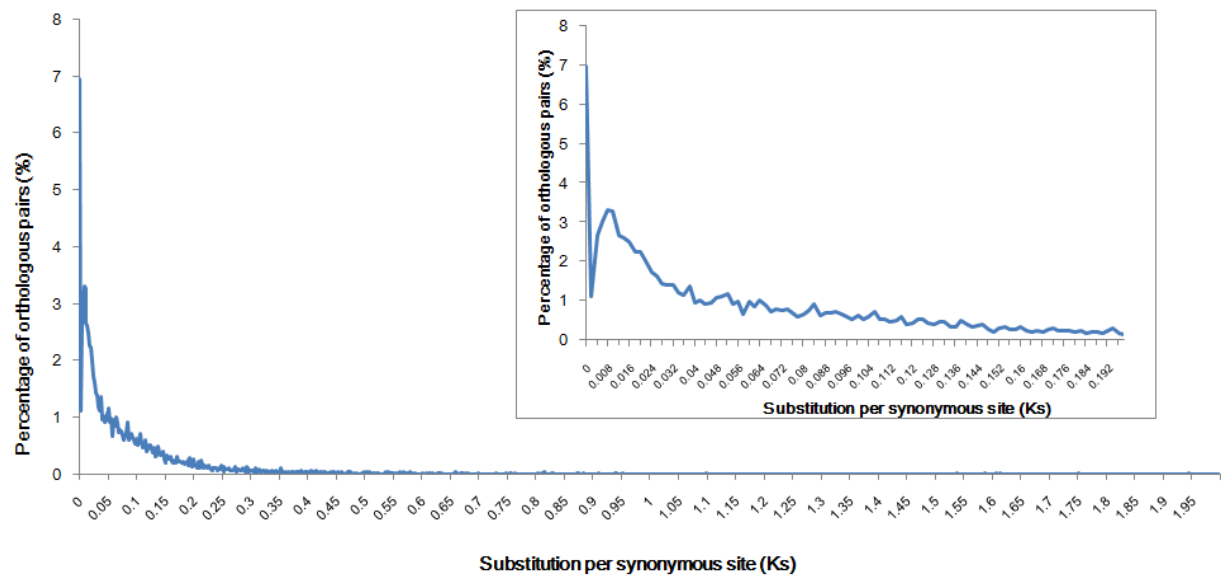
Figure 2. Ks distribution for identification of the speciation event. Data were grouped into bins of 0.002 Ks units for graphing. The Ks distribution of the orthologous pairs is plotted as the blue line and shows a distinct secondary peak, indicating the time of divergence of these two